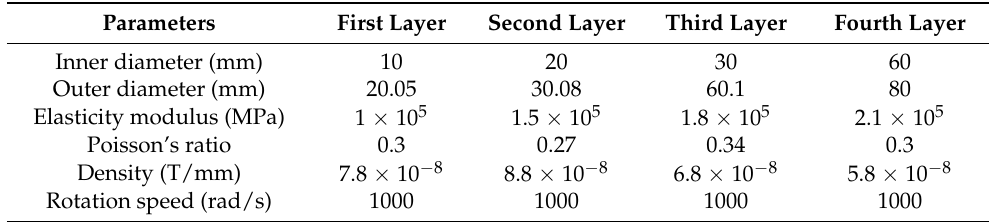
Figure 10. The stress nephogram of crack. To verify the accuracy of the finite element models, the contact pressure calculated by Equation (12) is used to verify the contact pressure of the three contact surfaces in a rotating thick-walled cylinder with four-layers without cracks. In the finite element model, the contact pressure P 2 of the first layer and the second layer is 187 Mpa. The con- tact pressure P 3 of the second layer and the third layer is 165 Mpa, and the contact pressure P 4 of the third and fourth layers is 47 MPa. The contact pressures P 2 – P 4 calculated by Equa- tion (12) are 186, 165, and 44.7 Mpa, respectively. The contact pressure calculated by the finite element model is approximately equal to that calculated by Equation (12); therefore, the accuracy of the finite element model can be verified. The crack face displacement u ( a, x ) is the most important parameter in the SIF equa- tion, which directly affects the results of the SIFs. The finite element models and Equation (13) were compared to verify the crack face displacement u ( a, x ) in the weight function.